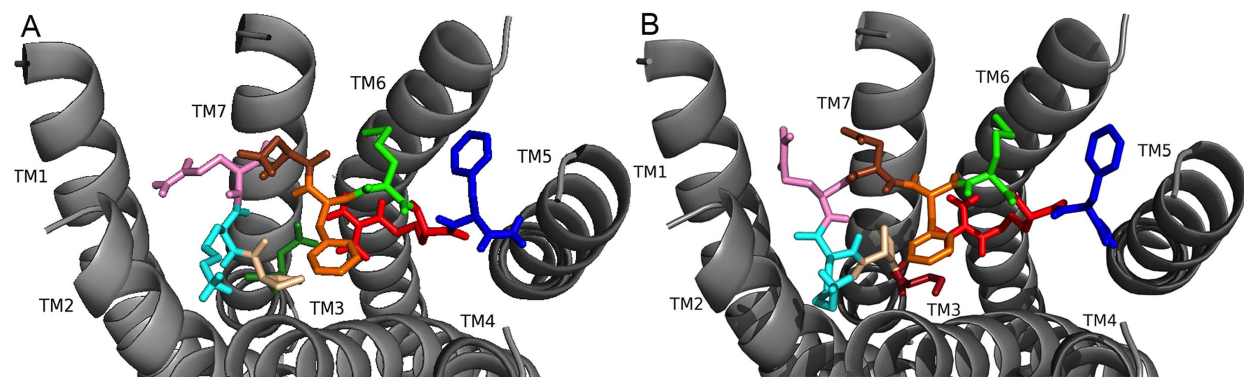
Figure 7. DPKQDFMRF-NH 2 and SPDKQDFMRF-NH 2 docked to FMRFa-R. Contacts made between the amino acids in DPKQDFMRF-NH 2 are shown as D (forest green), P (tan), K (cyan), Q (light pink), D (brown), F6 (orange), M (green), R (red), and the C-terminal F as dark blue and the receptor, FMRFa-R, whose transmembrane regions are labeled TM # where # is 1–7 (see A). The C-terminal F was amidated, -NH 2 . Contacts made between the amino acids in SPKQDFMRF-NH 2 are shown as S (brick red), P (tan), K (cyan), Q (light pink), D (brown), F6 (orange), M (green), R (red), and F9 (blue) and the receptor, FMRFa-R, whose transmembrane regions are labeled TM # where # is 1–7 (see B). The C-terminal F was amidated, -NH 2 .